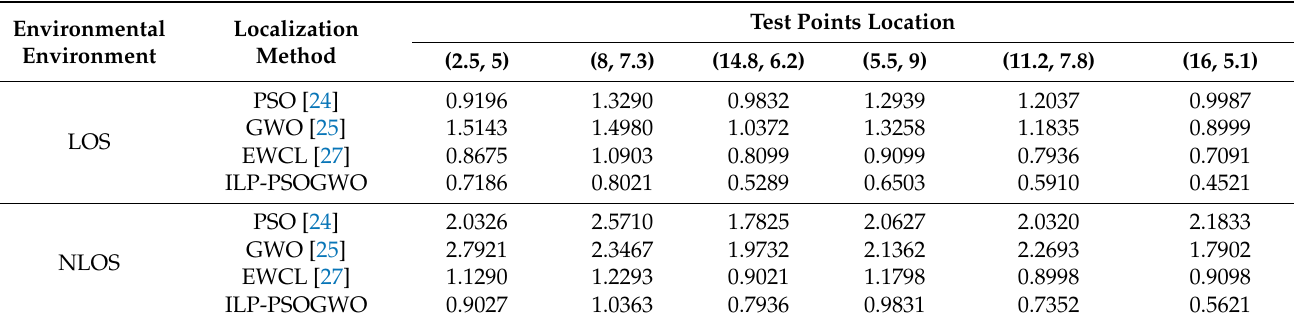
Table 2. The impact of target node location on localization error.